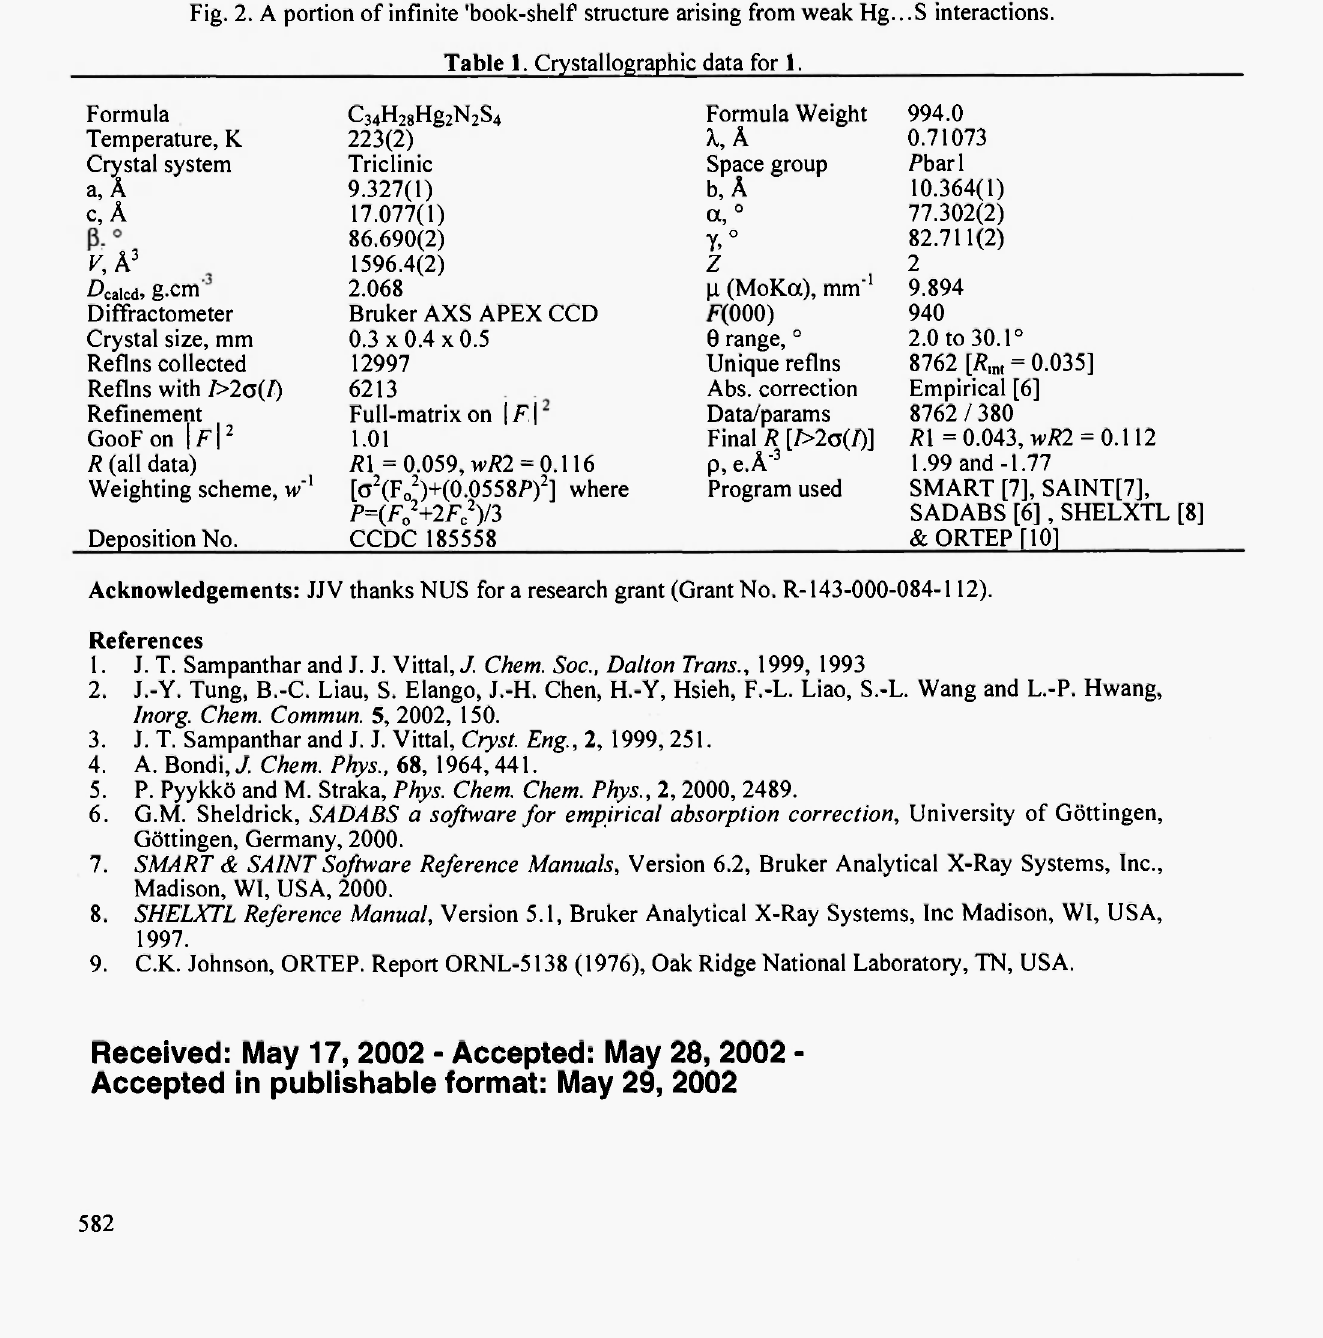
Fig. 2. A portion of infinite 'book-shelf structure arising from weak Hg...S interactions. Table 1. Crystallographic data for